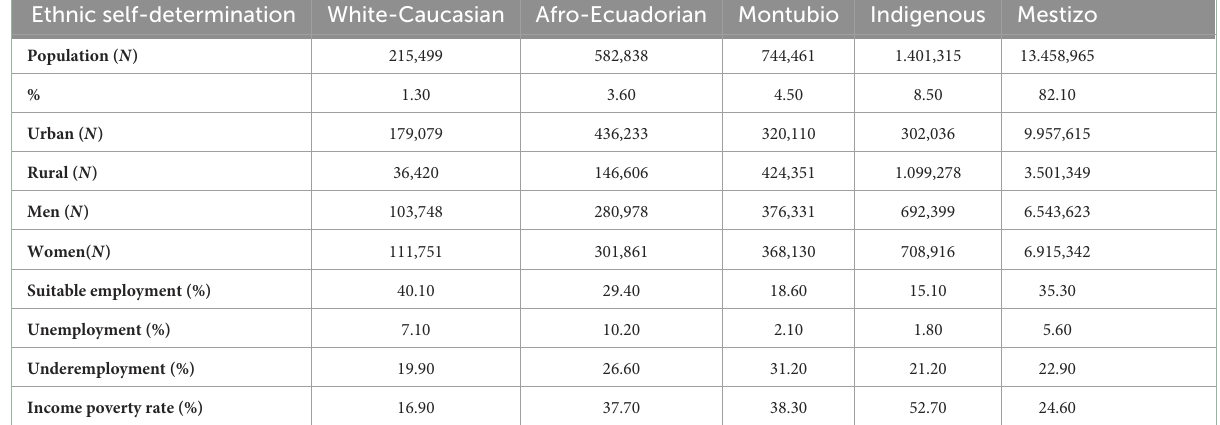
TABLE 1 Population distribution by ethnicity in Ecuador. Ethnic self-determination